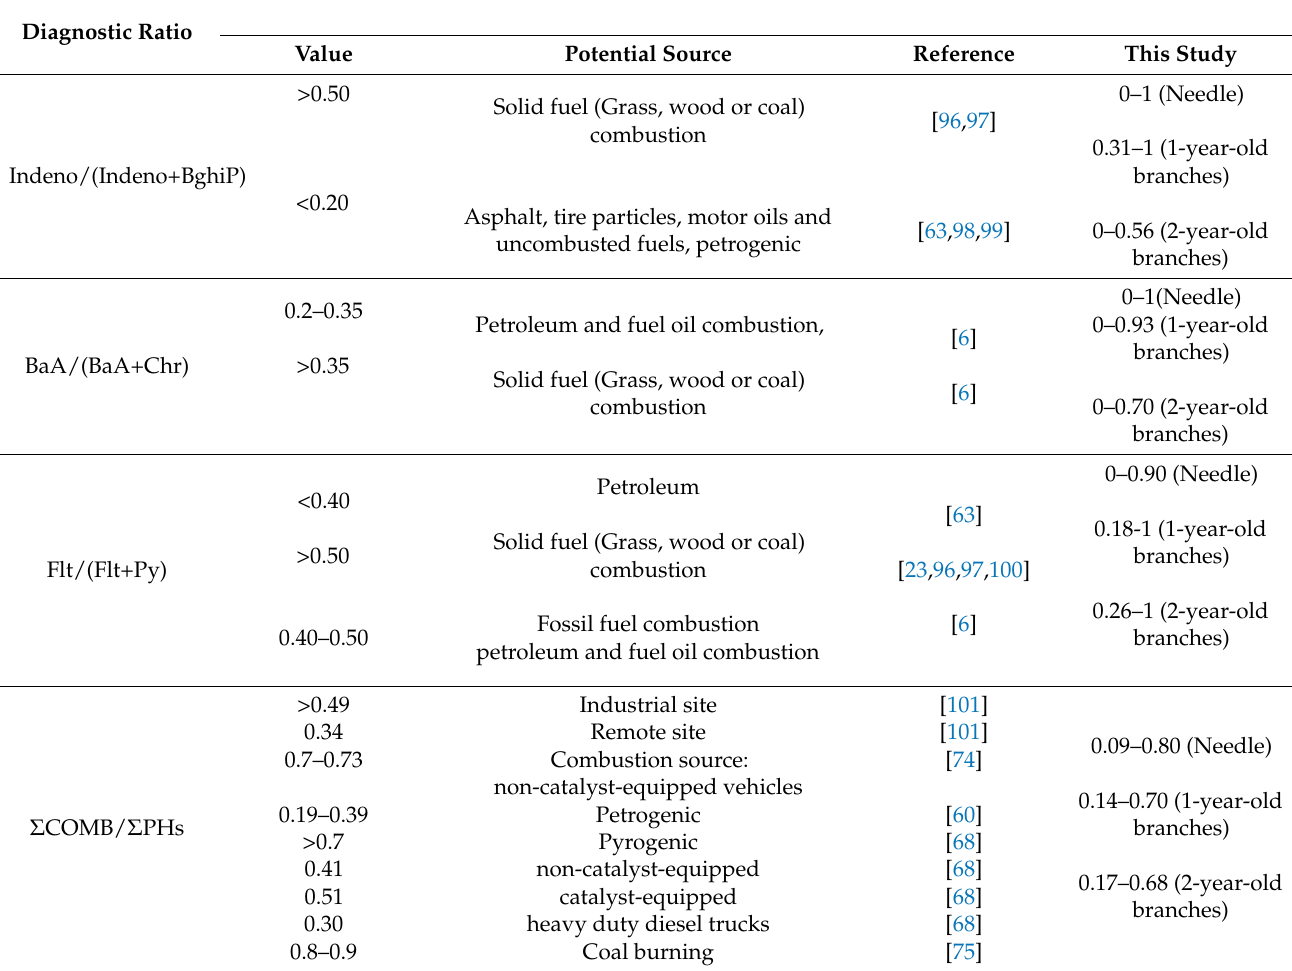
Table 6. Diagnostic ratios of PAHs in pine